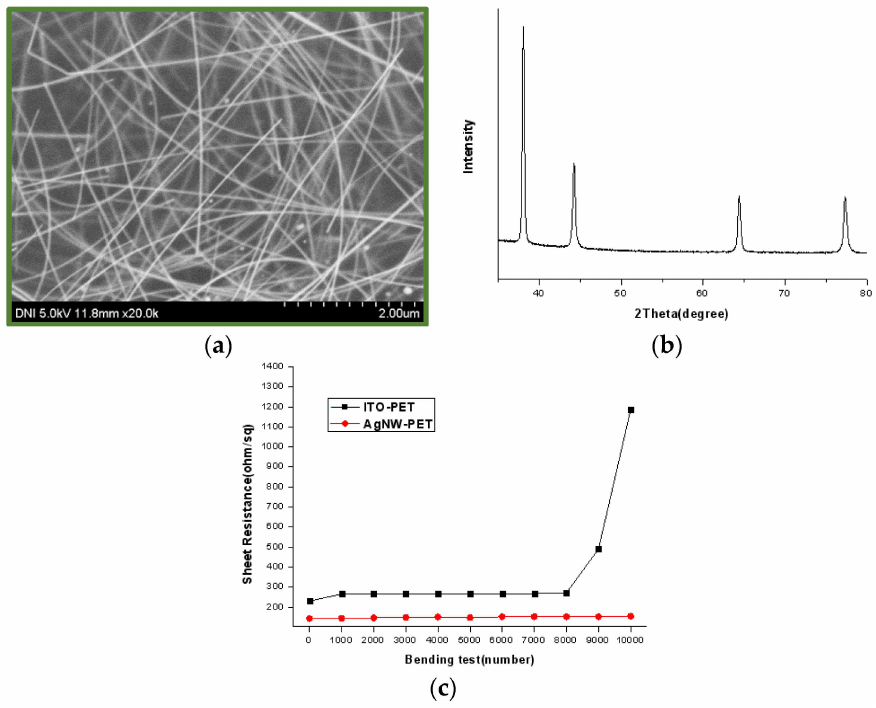
Figure 8. ( a ) SEM image of AgNW-PET film; ( b ) XRD peak of AgNW; and ( c ) bending test of AgNW-PET